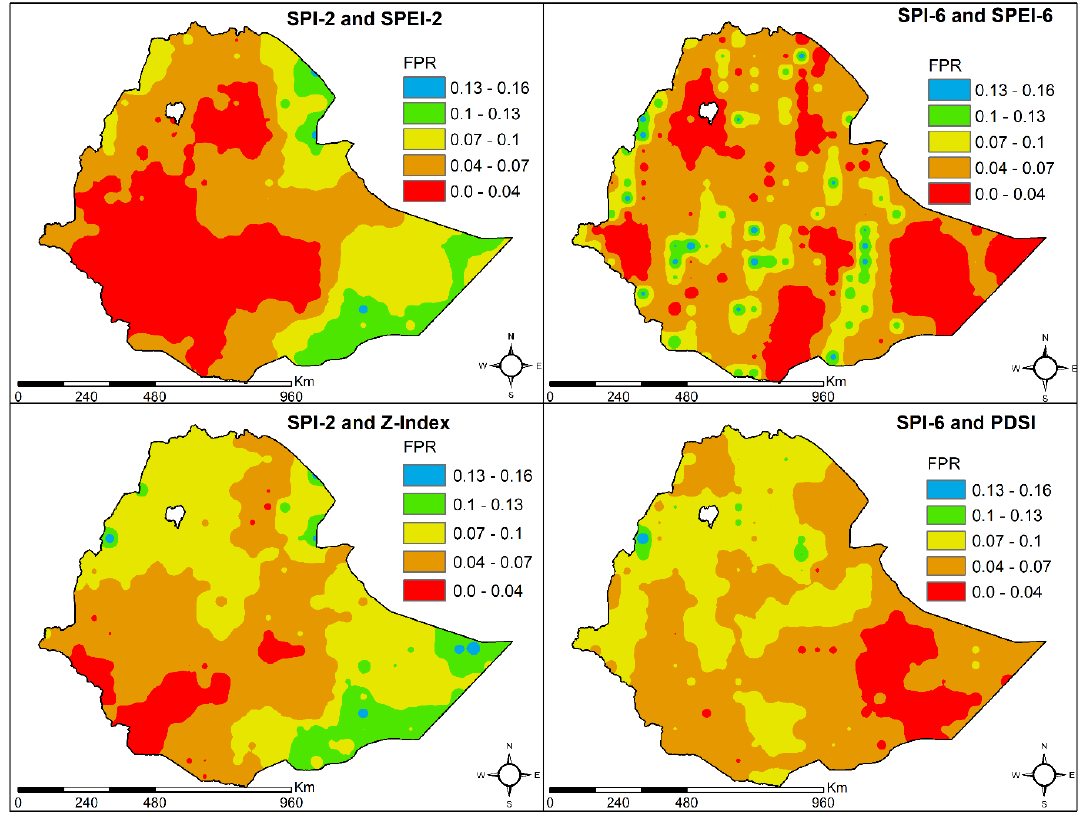
Figure 7. False Positive Rate (FPR) for various drought indicator combinations across Ethiopia.